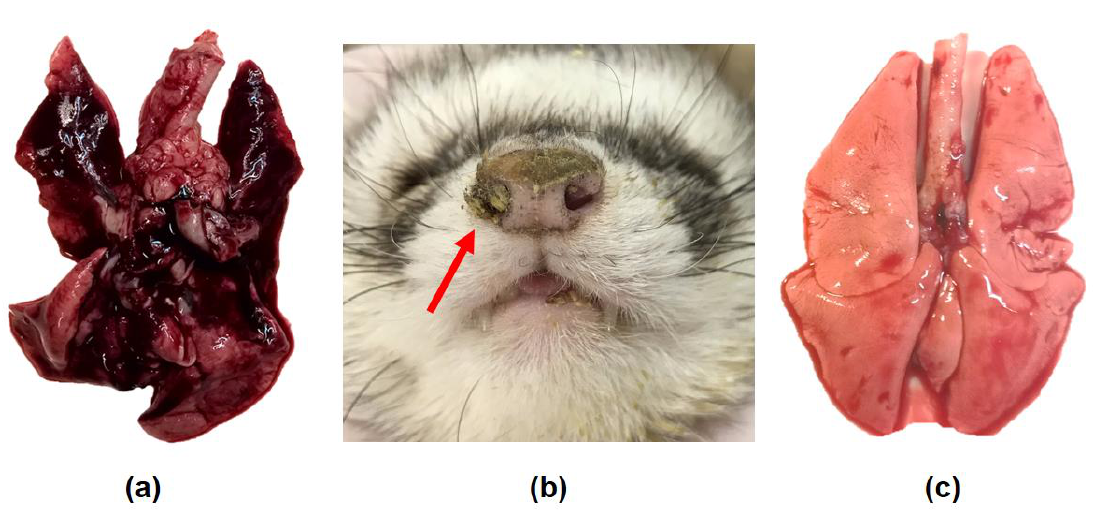
Figure 6. Body temperature of the ferrets after infection with the SA influenza virus: ( a ) variation in the body temperature until 4 days post infection (raw data). The temporary decreases in temperature were the result of sedation during the collection of nasal washes. The body temperature was recorded by temperature loggers every 10 min; ( b ) the difference between the infected group and the control group, represented by the mean ± SD, p < 0.05. 3.6. Phylogenetic Characterization of H1N1pdm09 Viruses The analysis of the H1N1pdm09 viruses that circulated between 2009 and 2014 revealed that the HA and NA of the A/California/07/2009 reference virus were genetically distinguished from those of